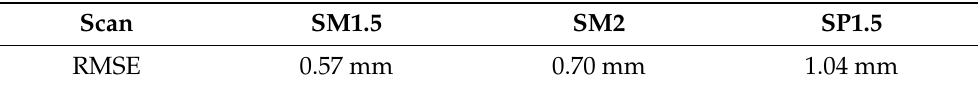
Table 4. Raster-to-raster RMSE between SfM and design geometry. Marked pattern artifact at 1.5 m (SM1.5) and 2.0 m (SM2) and projected light pattern artifact at 1.5 m (SP1.5). Scan